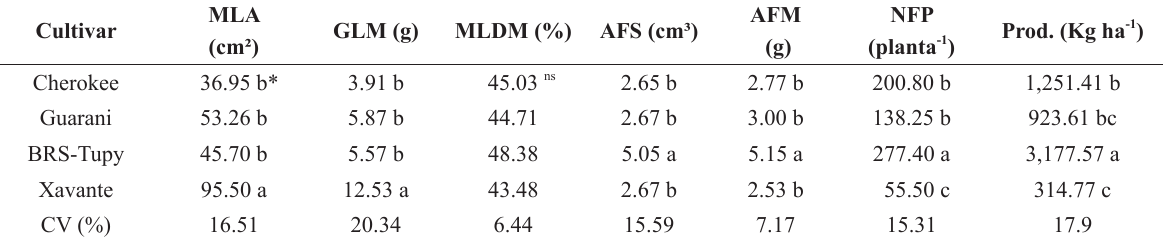
Mean leaf area (MLA), green leaf mass (GLM) mass of leaf dry matter (MLDM), average fruit size (AFS), average fruit mass (AFM), number of fruits per plant (NFP) and productivity according to the cultivar of blackberry. Chapecó, SC,